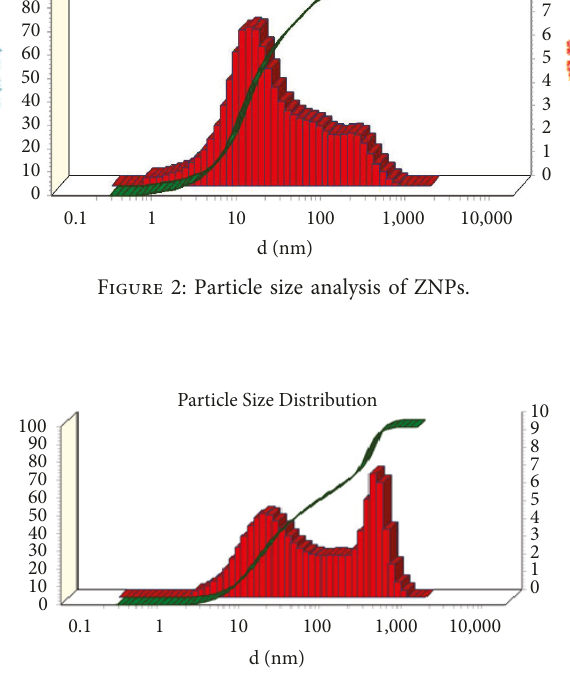
Figure 3: Particle size analysis of activated carbon.